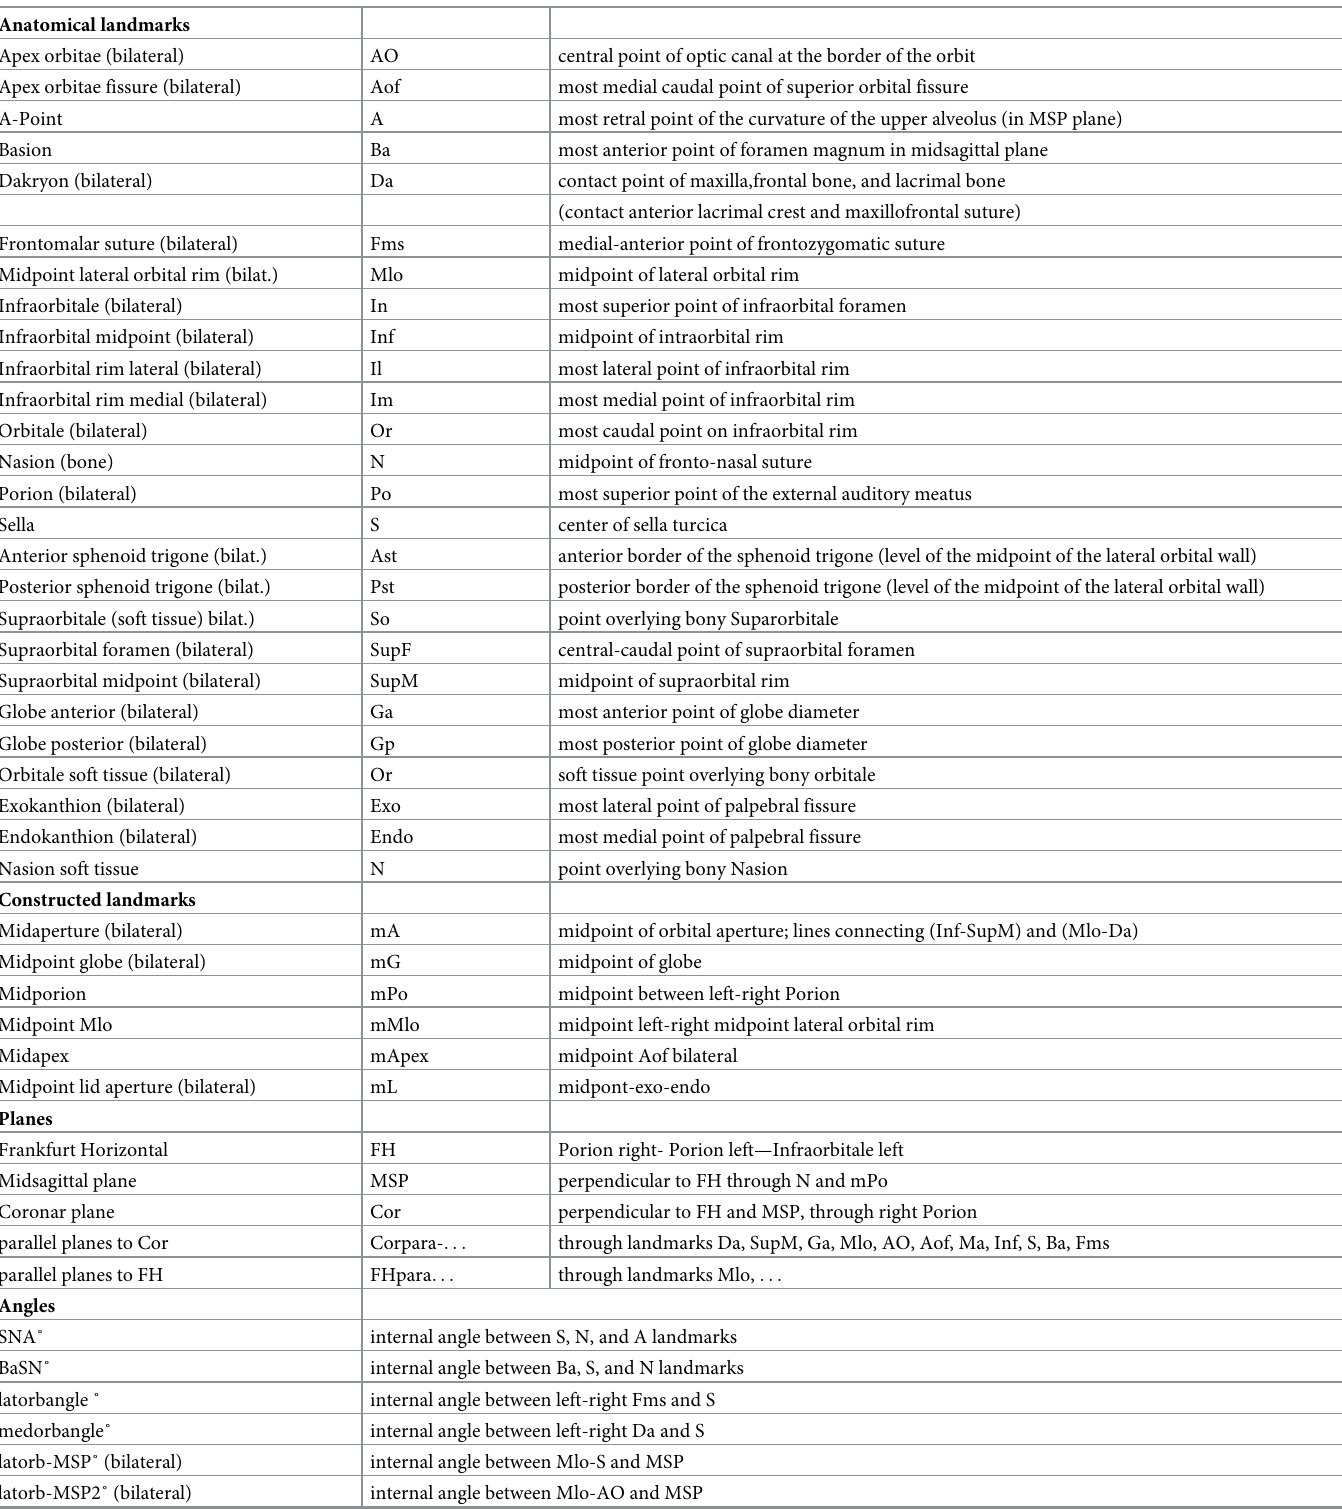
Table 1. 3-D landmarks placed in FAT and their respective definitions, constructed planes and angles. Anatomical